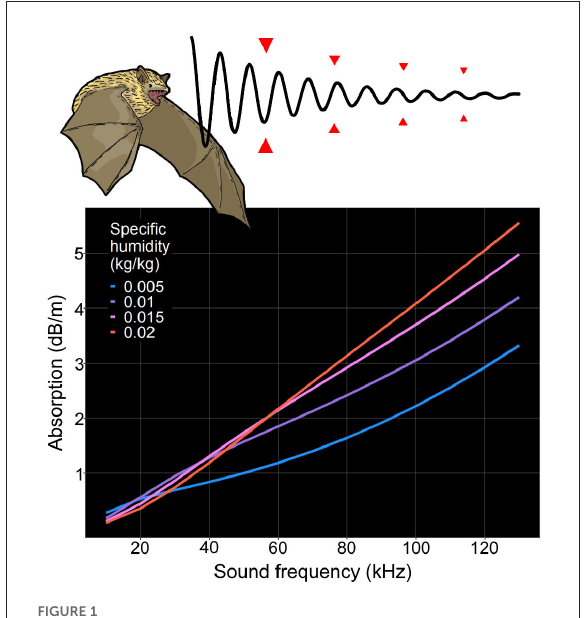
FIGURE1 Attenuation hypothesis: bat echolocation is subject to atmospheric absorption, which effectively decreases the detection range, especially in the higher end of the frequency spectrum. The slope of the relationship between absorption and frequency increases with specific humidity. Thus, humidity increases the cost of evolving higher echolocation frequency. Calculation of absorption is carried out with an ISO 9613-1-based online calculator (National Physical Laboratory,